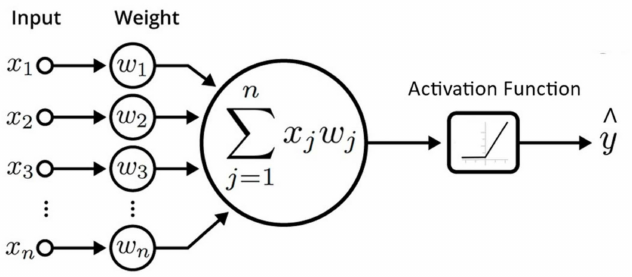
Figure 1. Representation of Artificial Neural Network as Shallow